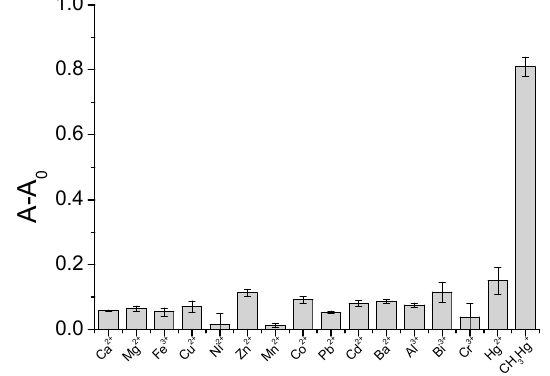
Figure 5. Selectivity of the colorimetric assay for CH 3 Hg + .